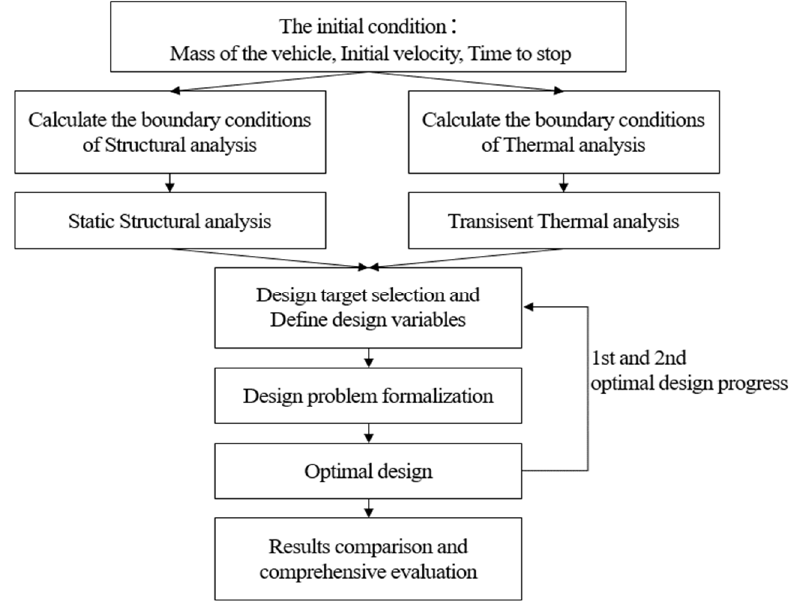
Figure 1. Optimal design procedure for brake discs based on thermal and structural finite element analysis.